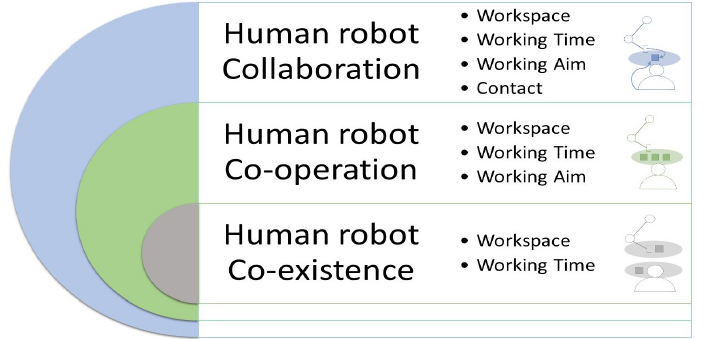
Figure 2. Classification of human–robot